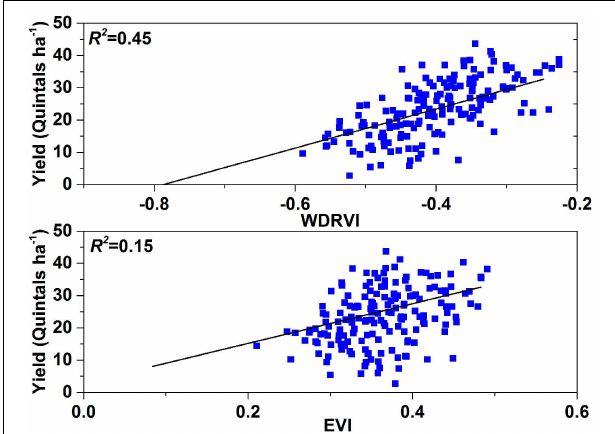
FIGURE 5 | The relationship between block-wise kharif rice crop yields reported via agricultural statistics and block-wise weighted average peak WDRVI (upper panel) and EVI (lower panel) calculated using MODIS MOD09A1 data. The weight of each pixel’s peak EVI in the calculation of block average peak EVI corresponds to the proportion of cropland within each pixel determined using two Landsat (30m spatial resolution) crop maps (one from the 2002 kharif season and one from the 2009 kharif season). Here, only pixels with at least 50% cropland cover were retained for further analysis as in Bolton and Friedl (2013). Rice crop growing season and peak VI were extracted using a method similar to that outlined in Dash et al. (2010), but, with adapted thresholds. This analysis was performed for two districts (Jagatsinghpur and Kendrapara) in Odisha, India, from the 2001–2002 to the 2010–2011 cropping